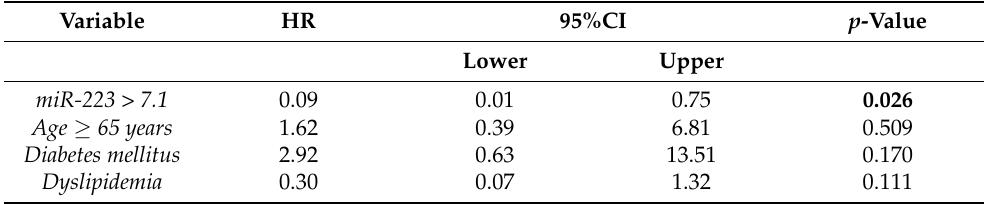
Table 4. Multivariate Cox regression model for prediction of long-term all-cause